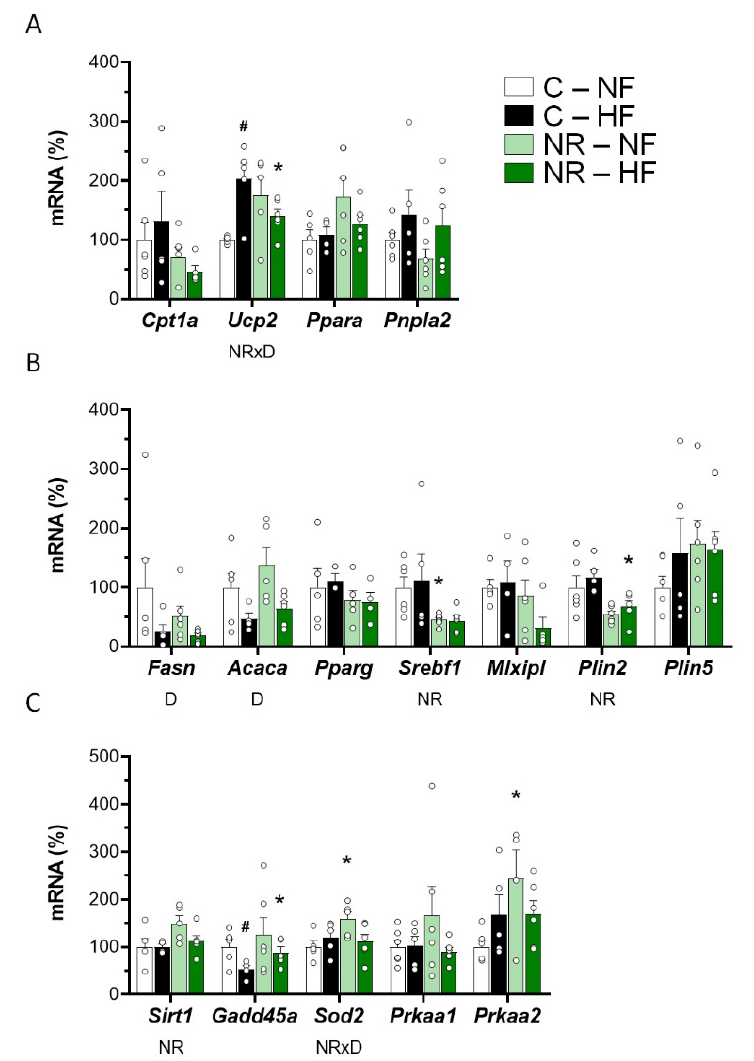
Figure 5. Early-life nicotinamide riboside (NR) treatment modified lipid metabolism capacities in the liver in adulthood. Newborn male mice received NR or vehicle (water; control) from day 2 to 20 of age, were weaned onto a chow diet on day 21, and were assigned to either an HF or a normal-fat (NF) diet on day 90 for 10 weeks. mRNA levels of the indicated genes related to fatty acid oxidation/lipolysis ( A ), lipogenesis/lipid droplet ( B ), and SIRT1 and AMPK pathways ( C ) were analyzed in the liver at the end of the experiment. Data are the mean ± SEM of 5–6 animals per group and are expressed relative to the mean value of the NF-control group, which was set to 100. Circles correspond to individual data. Statistics ( p < 0.05): NR treatment, D diet, and NRxD treatment per diet interaction (two-way ANOVA); * NR vs. control, # HF vs. NF ( t